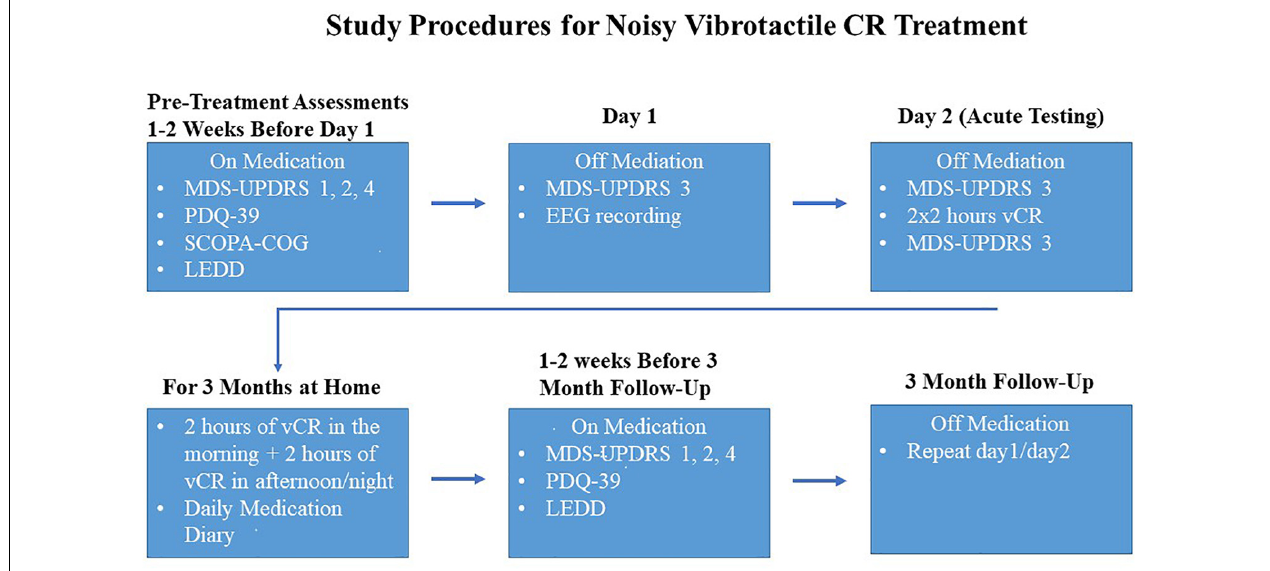
FIGURE 2 | Study procedures were as follows: 1–2 weeks before the first visit, while on medication, Parkinson’s disease (PD) patients took the Movement Disorders Society-Unified Parkinson’s Disease Rating Scale (MDS-UPDRS) parts 1,2, and 4, Parkinson’s Disease Questionnaire-39 (PDQ-39), Scales for Outcomes in Parkinson’s Disease-COGnition (SCOPA-COG) and reported levodopa equivalent daily dose (LEDD). On the first visit, PD patients were off medication and the MDS-UPDRS 3 was administered, followed by an at-rest electroencephalography (EEG). Patients withdrew their medication again overnight and on day 2 patients were assessed with a morning MDS-UPDRS part 3, followed by 2 × 2 h of vibrotactile coordinated reset (vCR) stimulation and then an afternoon MDS-UPDRS part 3 (directly after 4 h of stimulation) to assess acute effects of vCR. After day 2, patients were instructed at home to do 2 h of vCR treatment in the morning and 2 h in the afternoon or night. The assessments described above were then repeated at 3 months of vCR